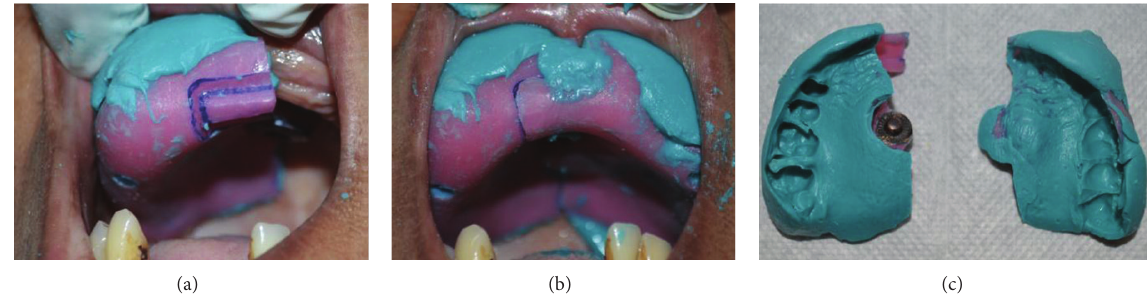
Figure 5: Impression making using the sectional tray Design